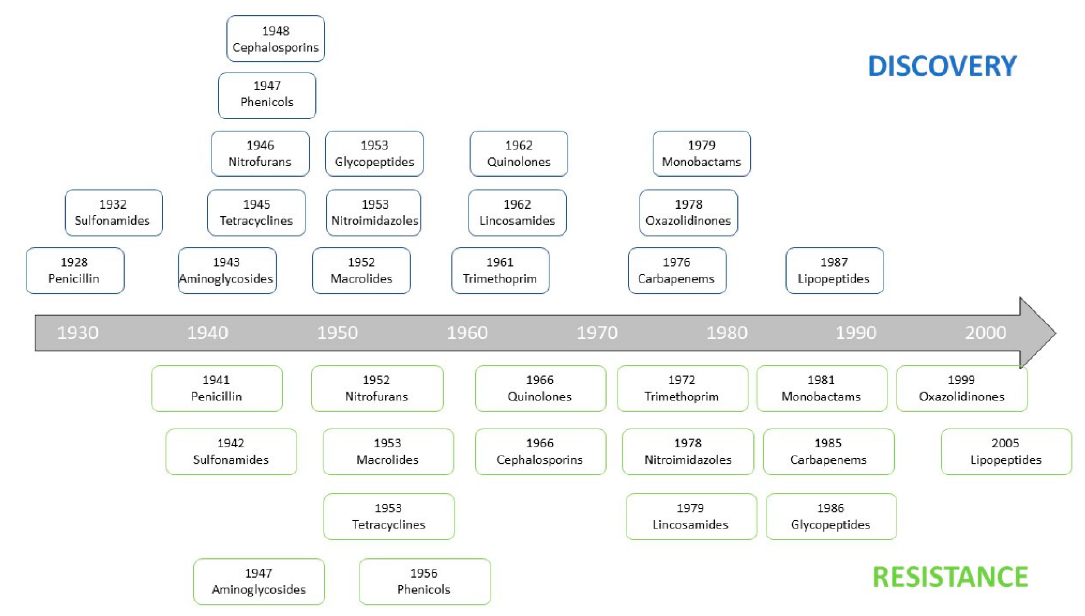
Figure 1. Antibiotics timeline [62].